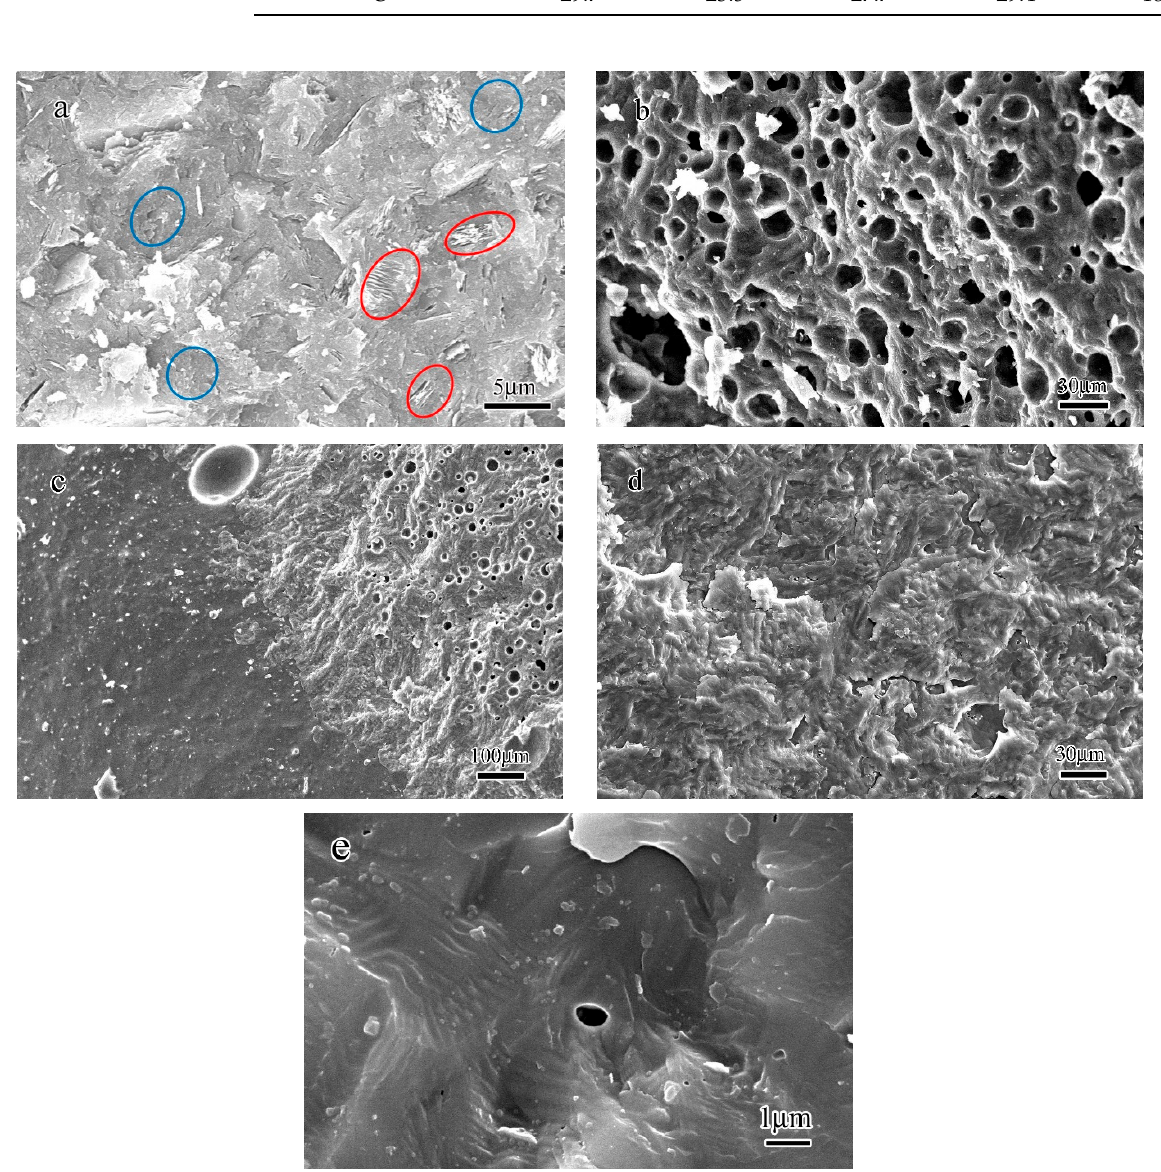
Figure 3. Fracture surface SEM images of the GP ( a ) before and after calcination at ( b ) 1000 °C, ( c ) 1100 °C, ( d ) 1200 °C and ( e ) 1400 °C.